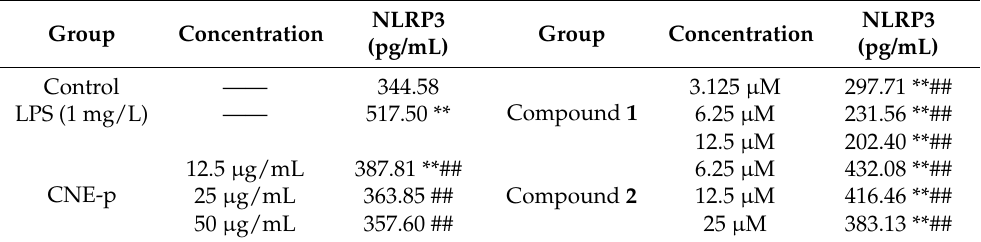
Figure 2. Influence of extracts obtained from C. nudiflora on changes in the inflammatory cytokines